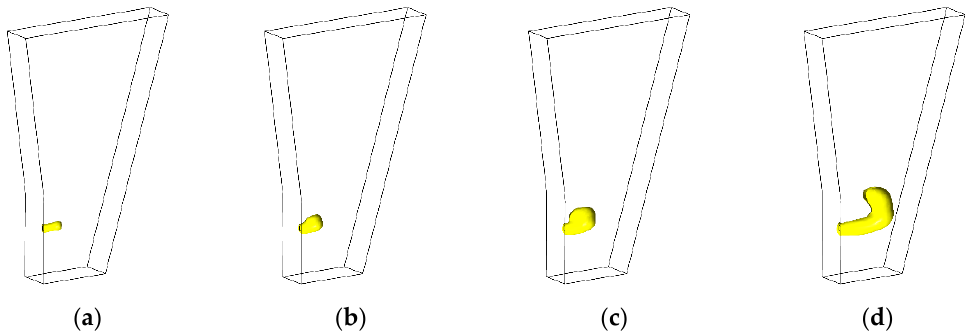
Figure 4. Raceway shapes after they stabilize at different blast velocities: ( a ) 150 m/s; ( b ) 200 m/s; ( c ) 250 m/s; ( d ) 300 m/s.